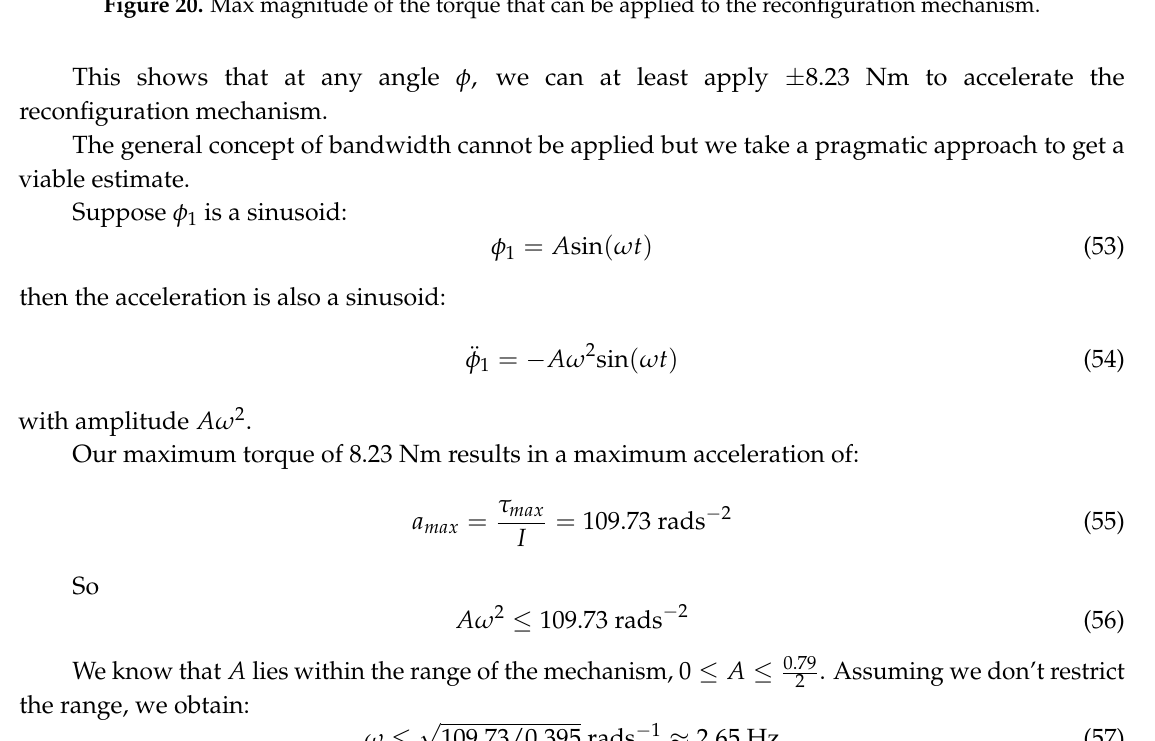
Figure 20. Max magnitude of the torque that can be applied to the reconfiguration